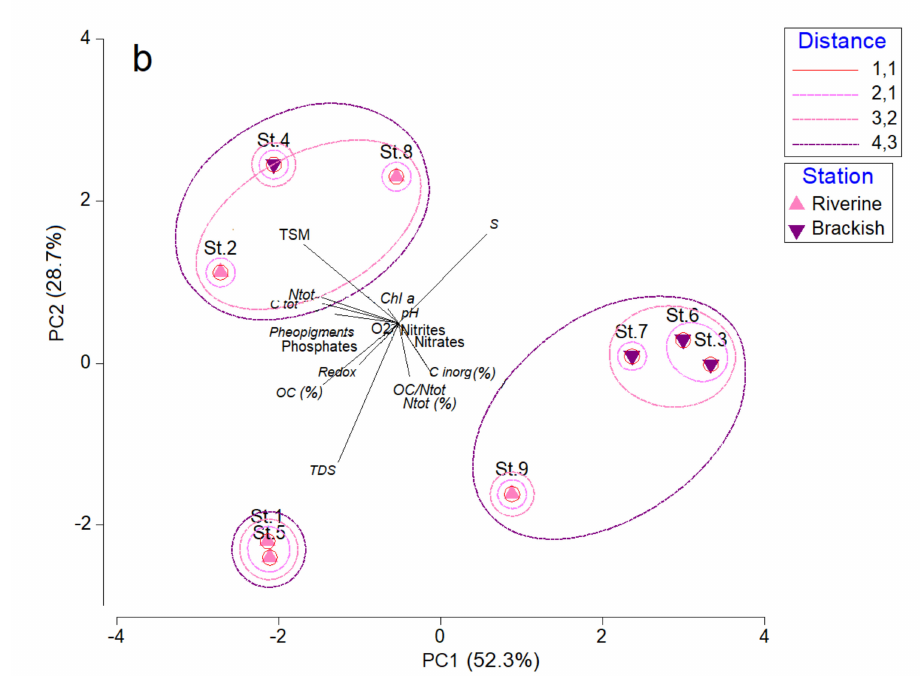
Figure 6. Principal Component Analysis (PCA) computed on Euclidean distance calculated with environmental parameters data recorded for each sampling point along the Pasvik River in Ice-melt ( − ) ( a ) and Ice-melt (+) ( b ). As shown in the nMDS in Figure 7, on which vectors from diversity data were super- imposed, in Ice-melt ( − ),riverine St. 1 fully separated from all the other stations, grouping together in a unique cluster with a similarity of 80% (Figure 7a). The same analysis applied to data from Ice-melt (+) showed a complete separation of St. 5 (Figure 7b).